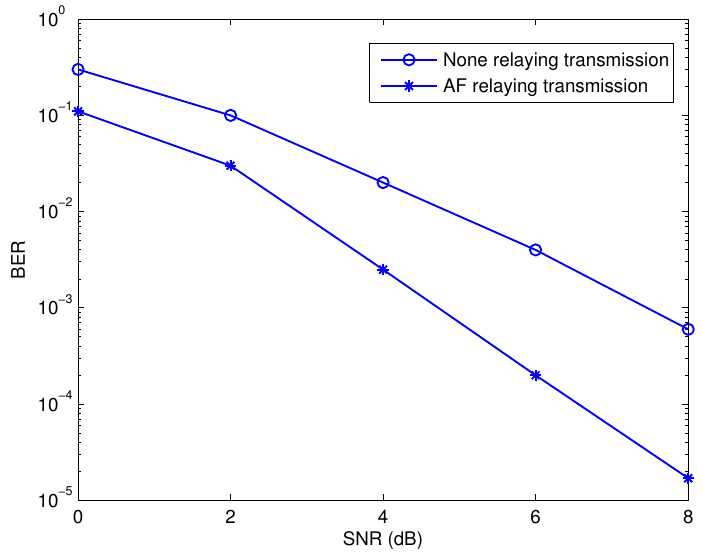
Figure 7. The proposed design’s performance with and without AF relaying